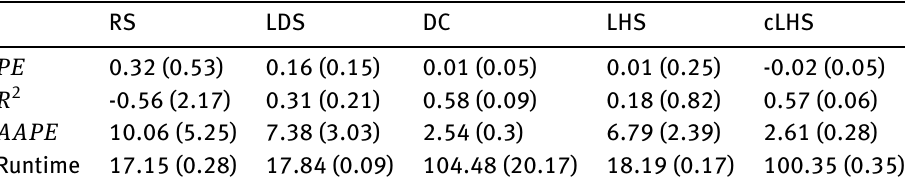
Table 3: Average accuracy and speed (in seconds) of the experimental design methods over 10 runs when s = 440 . The num- bers in parentheses are the corresponding standard deviations.